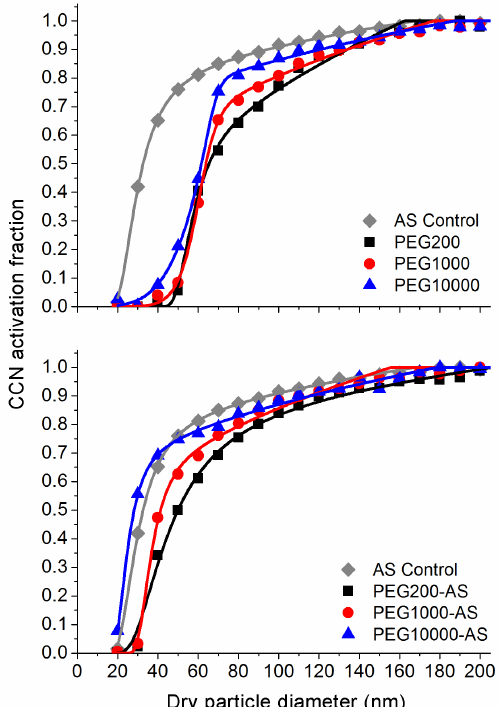
Figure 2. Measured cloud condensation nuclei (CCN) activation fractions as a function of dry particle size for (a) the PEG- containing aerosol systems and (b) the PEG–AS aerosol systems with PEG:AS mass ratios of 2 : 1. CCN activity was characterized based on the critical activation dry particle diameter at a water su- persaturation of 0.8%. Solid lines represent the sigmoidal curves fit to the activation fraction measurements for each aerosol system. Critical diameters are characterized based on the particle size cor- responding to a CCN activation fraction of 50%. Pearson- r values for the sigmoidal fits are > 0.99 for all aerosol